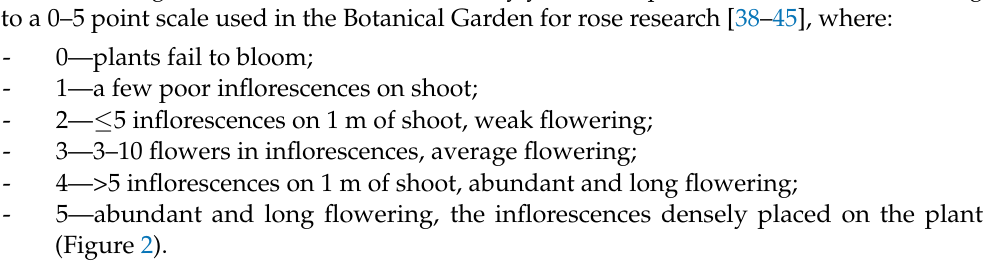
Figure 2. The abundance of flowering on a scale 0–5 in climber roses, where: ( a ) 0—plants fail to bloom; ( b ) 1—a few poor inflorescences on shoot; ( c ) 2—<5 inflorescences on 1 m of shoot, weak flowering; ( d ) 3—with 3–10 flowers in inflorescences, average flowering; ( e ) 4—>5 inflorescences on 1 m of shoot, abundant and long flowering; ( f ) 5—abundant and long flowering, the inflorescences densely placed on the plant.